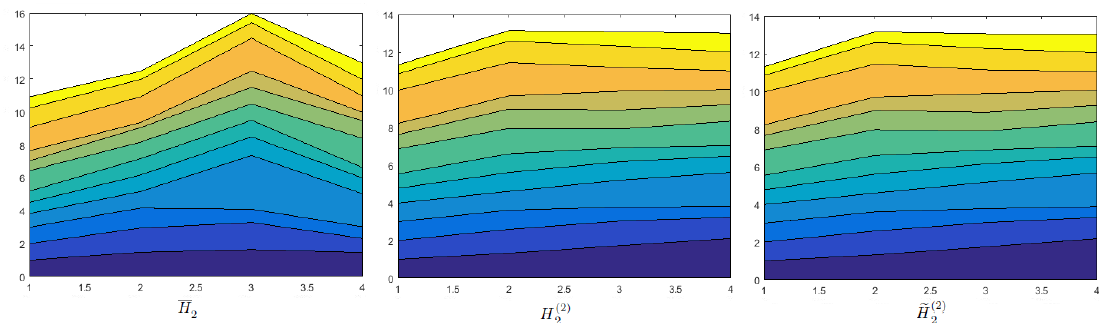
Figure 11. Area graphs of score values of H 4